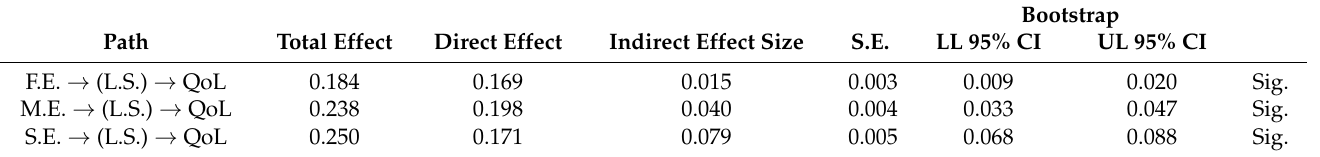
Table 6. Test of statistical significance for indirect